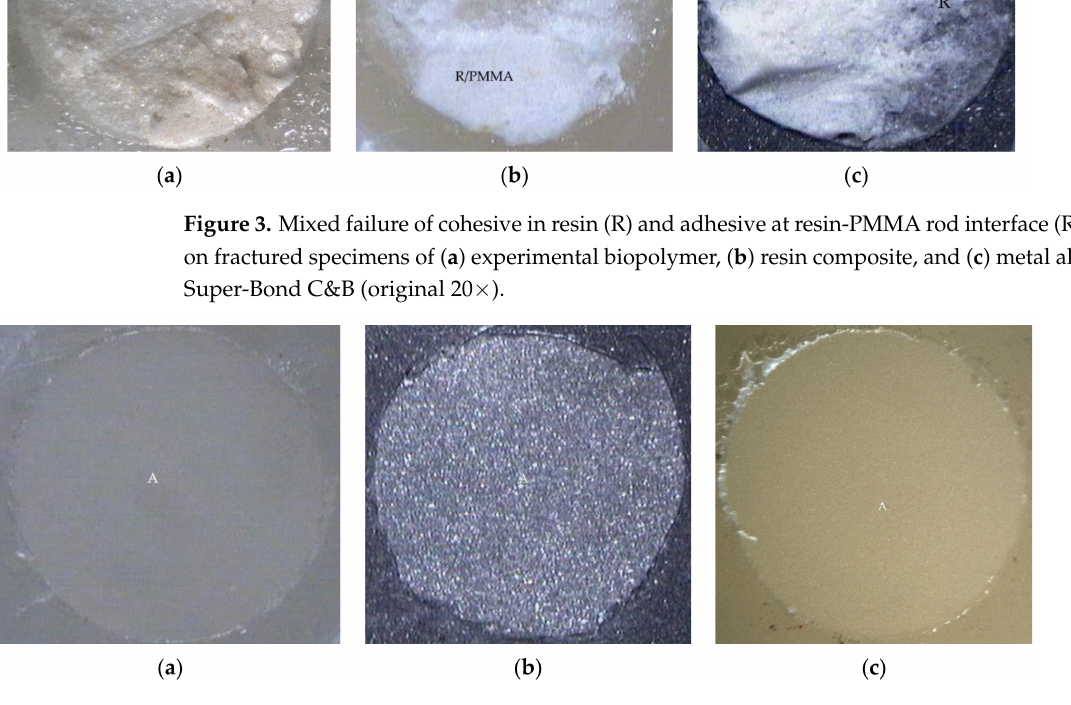
Figure 4. Adhesive failure on the prosthesis side interface (A) on fractured specimens of ( a ) ceramic,